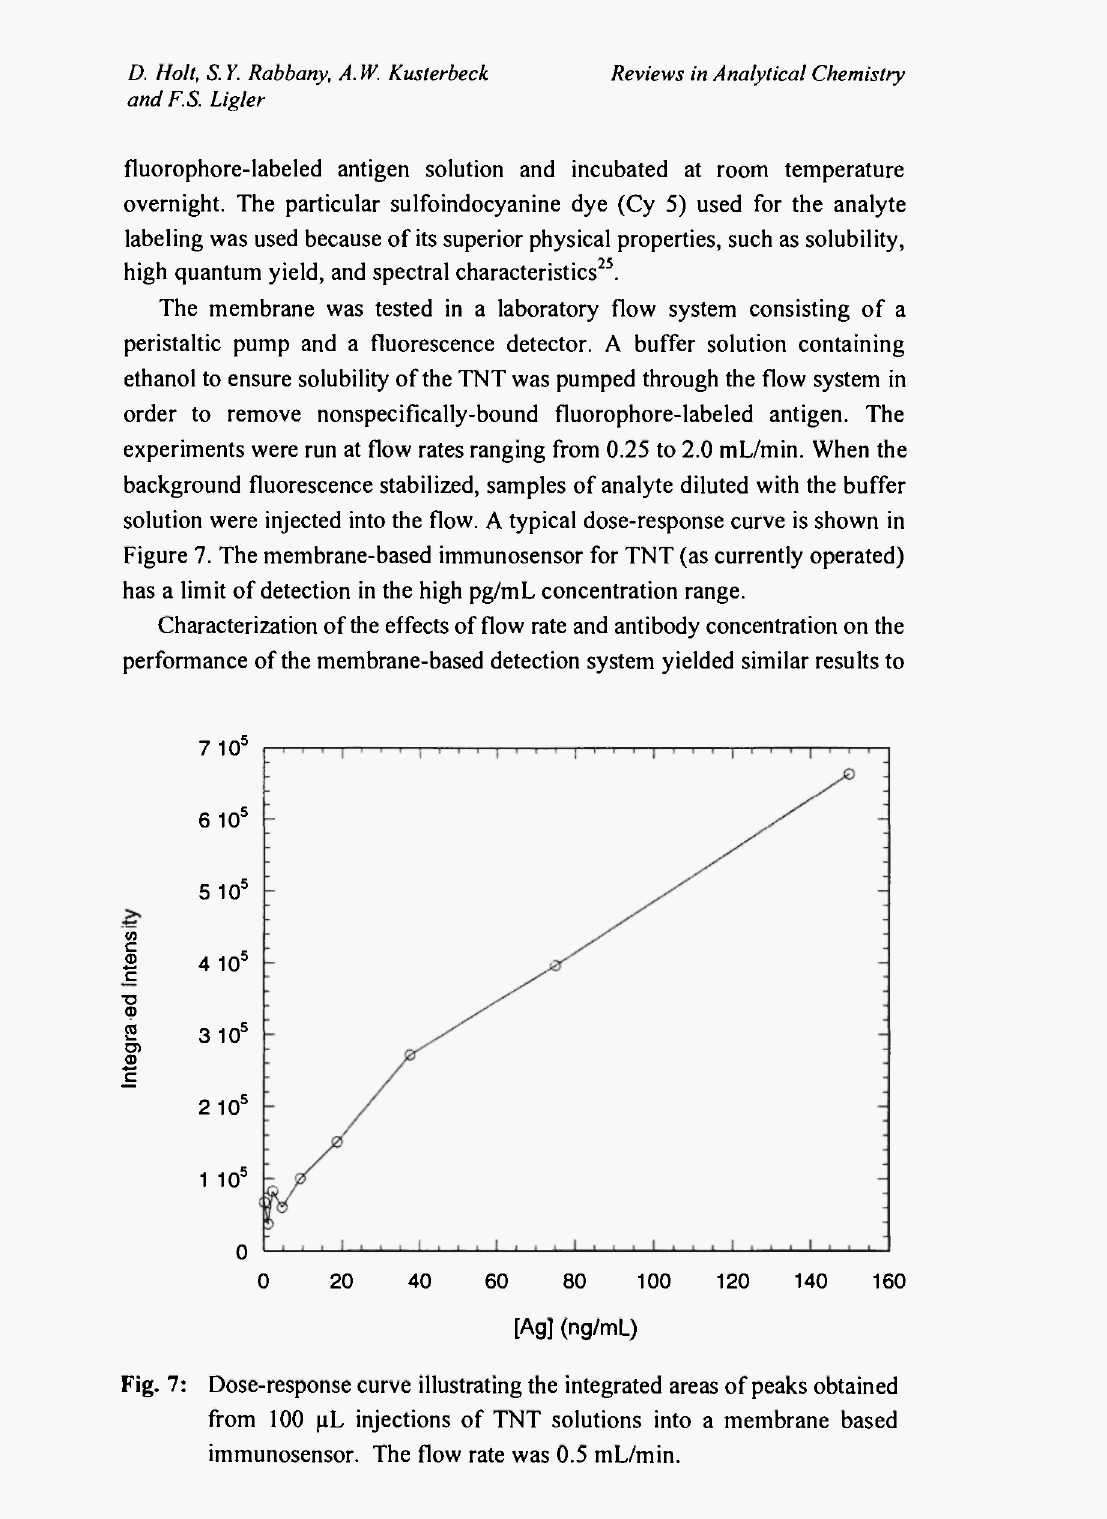
Fig. 7: Dose-response curve illustrating the integrated areas of peaks obtained from 100 μί injections of TNT solutions into a membrane based immunosensor. The flow rate was 0.5